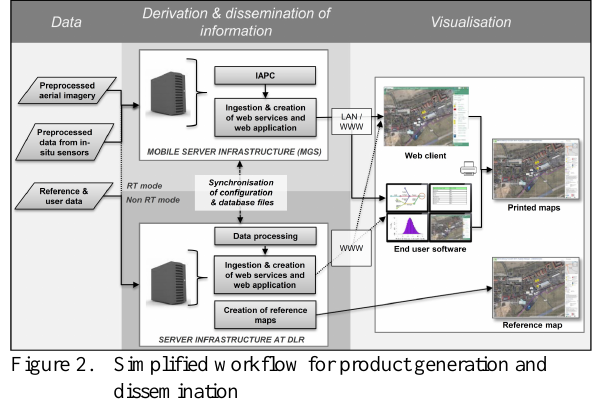
Figure 2. Simplified workflow for product generation and